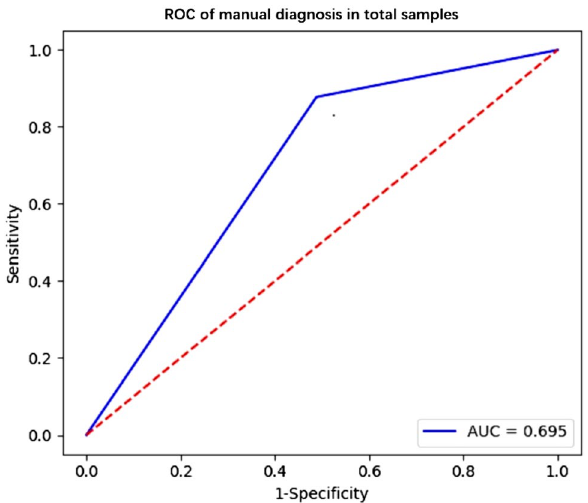
Figure 2. Receiver operating characteristic (ROC) curve analysis of radiologist diagnosis in the total samples, with the AUC of 0.69, sensitivity of 0.85, and specificity of